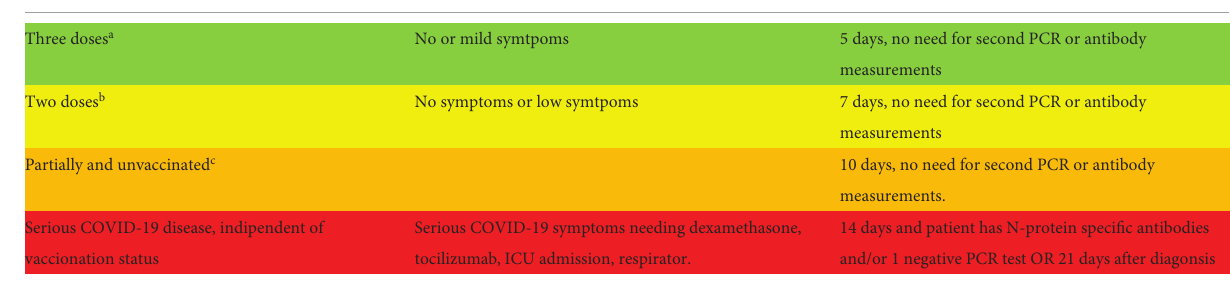
TABLE 1 Determination of non-infectivity in relation to vaccination status and